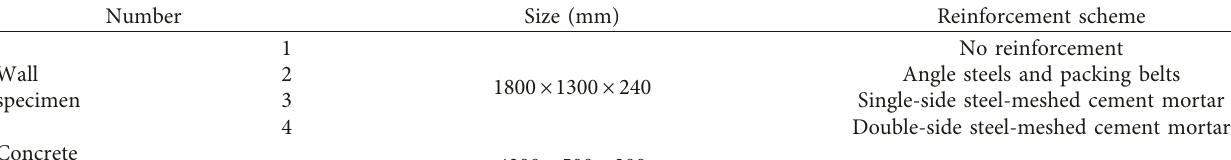
Table 1: Sizes of specimens and reinforcement schemes.